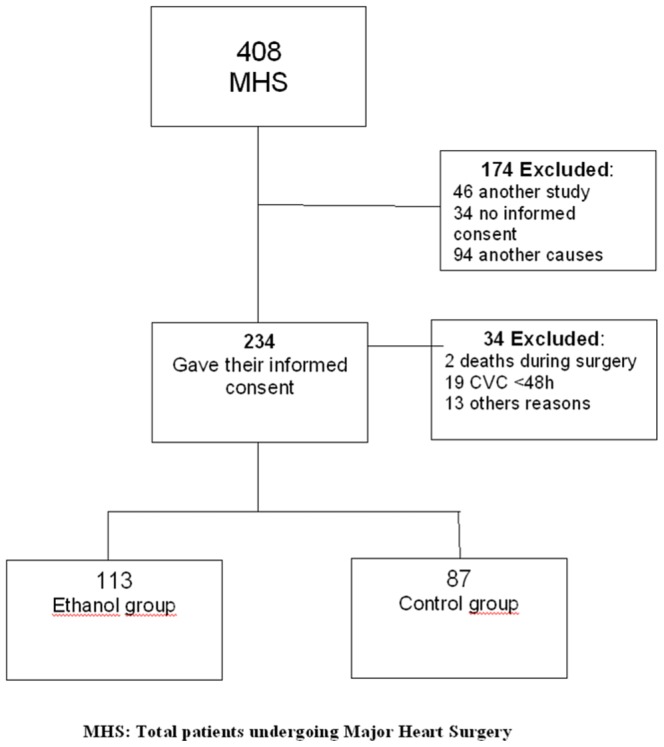
Selection of patients for the study.